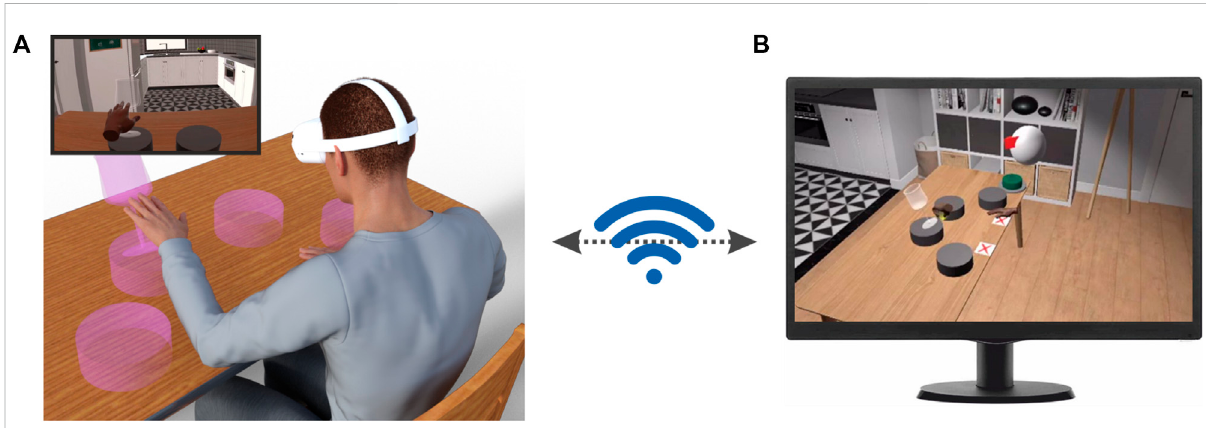
FIGURE 1 Application scenario of our immersive VR environment. (A) The patients are immersed in a VR environment by means of a head-mounted display (HMD, Oculus Quest 2, Facebook Reality Labs). In this environment, they can see different objects with which they can interact. The inset shows